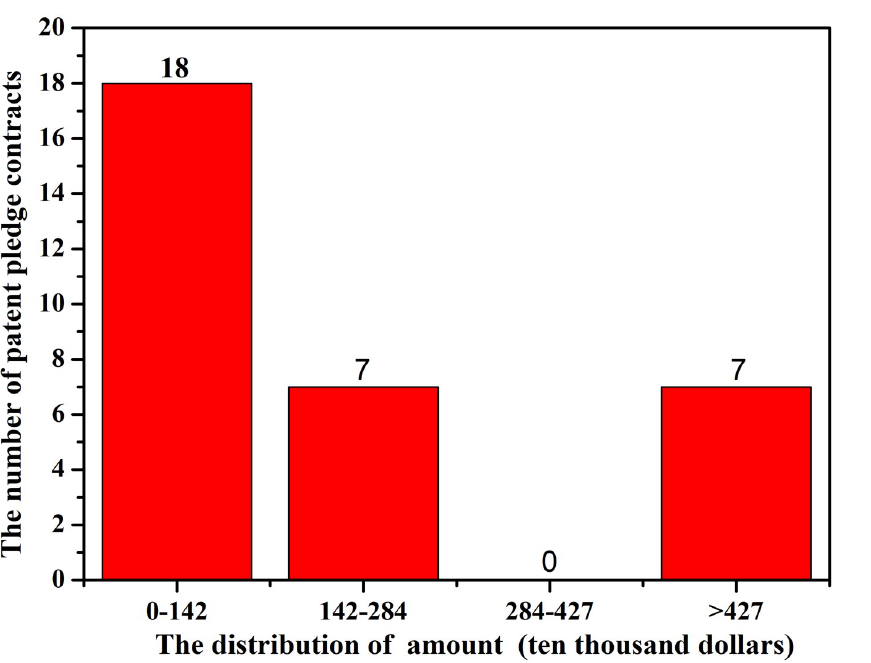
Fig 3. The distribution of patent pledge financing